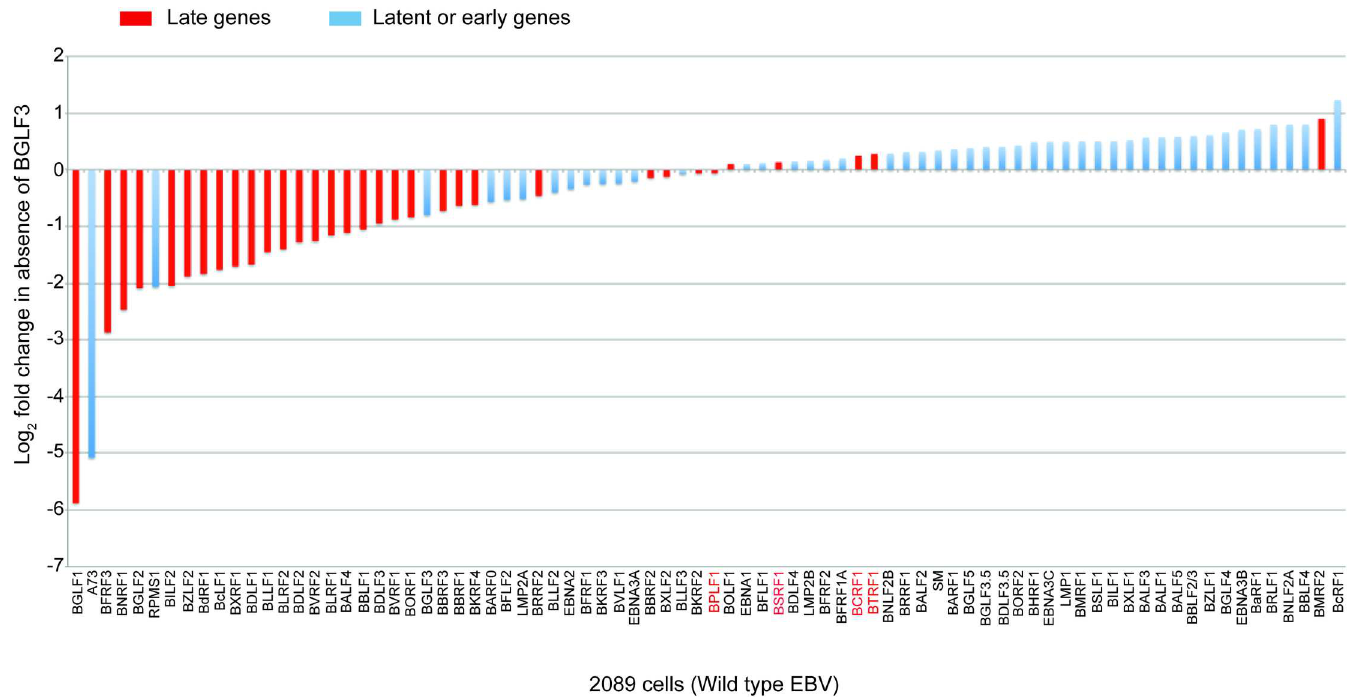
Fig 1. Knockdown of BGLF3 spares the expressionof a subgroup of late genes. Comparison of the EBV transcriptome in the absenceand presence of siRNA to BGLF3 (siBGLF3). Deep sequenceanalysiswas performed on mRNA purifiedfrom ZEBRA-transfected 2089 cells at a late time point (48h) duringlytic infection. Red bars represent fold-change in expressionof late genes; bluebars represent latent and early genes. Fold-change in expressionwas calculatedas the ratio of the numberof normalized reads per transcript in the presenceof siBGLF3 to the numberof reads in the absenceof siBGLF3. BPLF1, BSRF1, BCRF1 and BTRF1 represent lytic EBV genes previously categorized as late but were expressedin the absenceof the late gene regulator, BGLF3. This subclassof genes is referred to as BGLF3-independentlate genes.